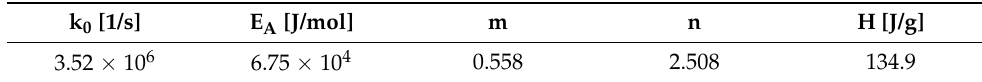
Table 2. Cure kinetic parameters for epoxy